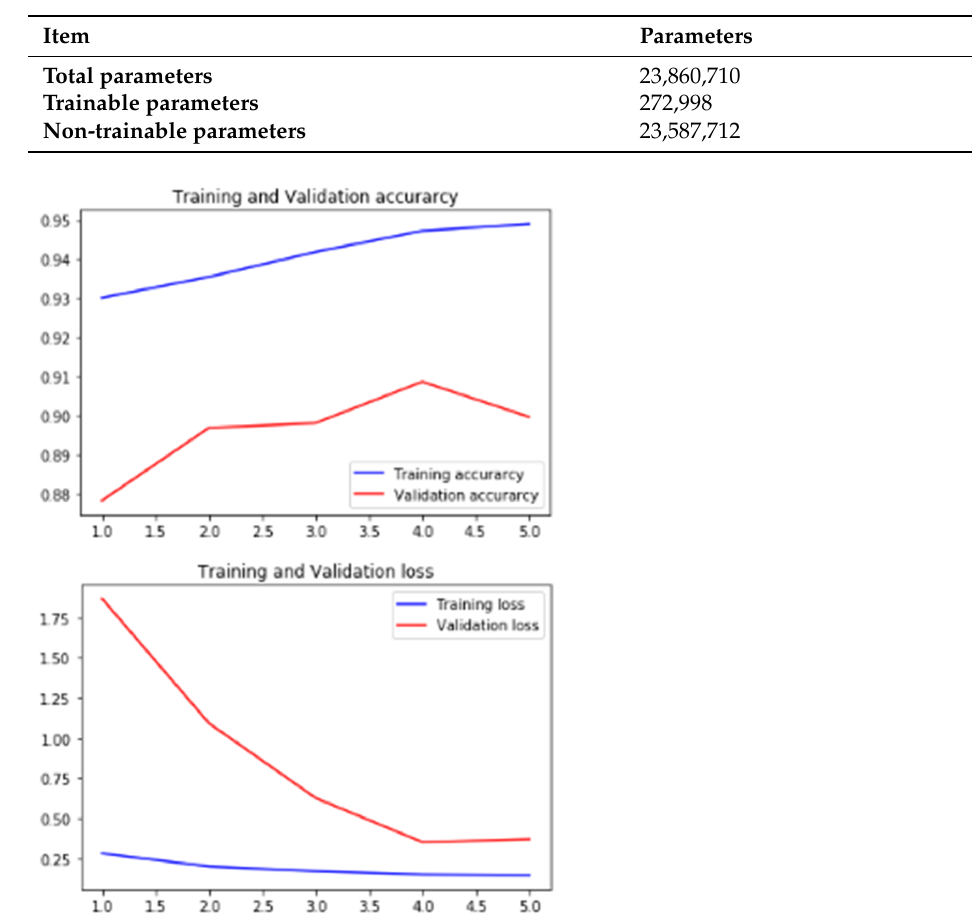
Table 3. ResNet network model parameters.